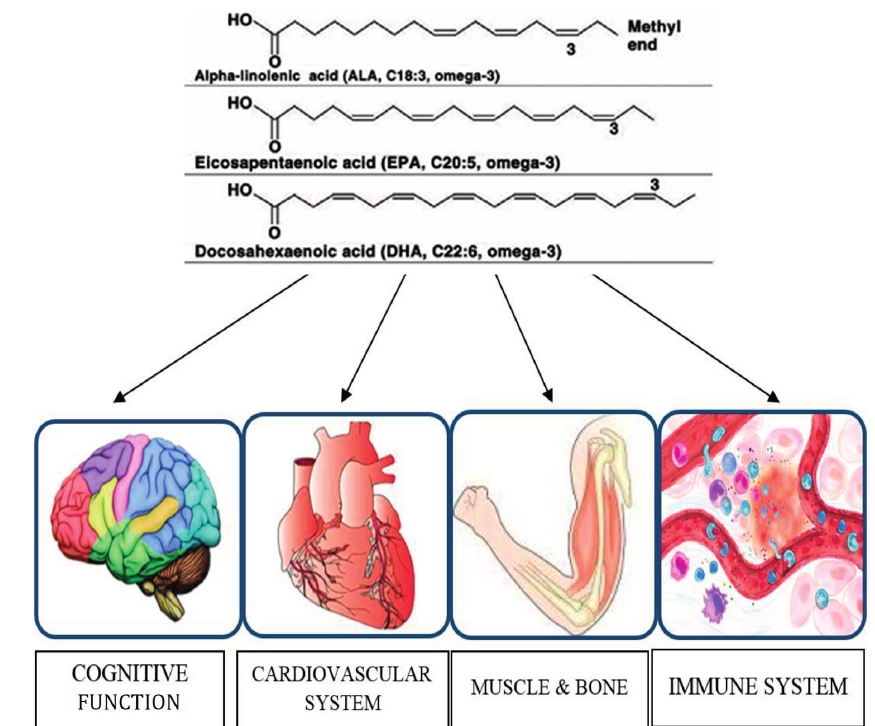
Figure 1. Organs and functions modulated by omega-3 PUFAs in older